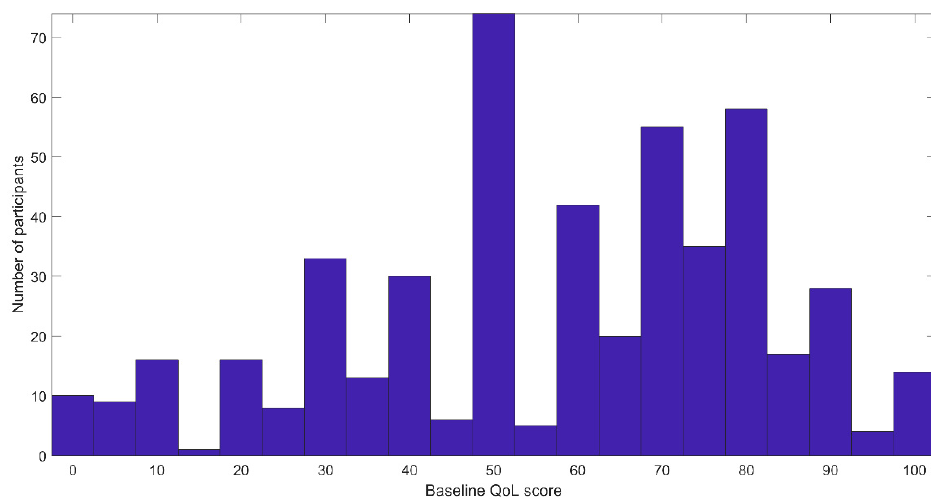
Figure 3. Histogram of baseline QoL scores. The demographic characteristics of the participants are listed in Table 1. Table 1. Demographic characteristics of participants enrolled in a treatment program for opioid use disorder with measured QoL ( n = 494).